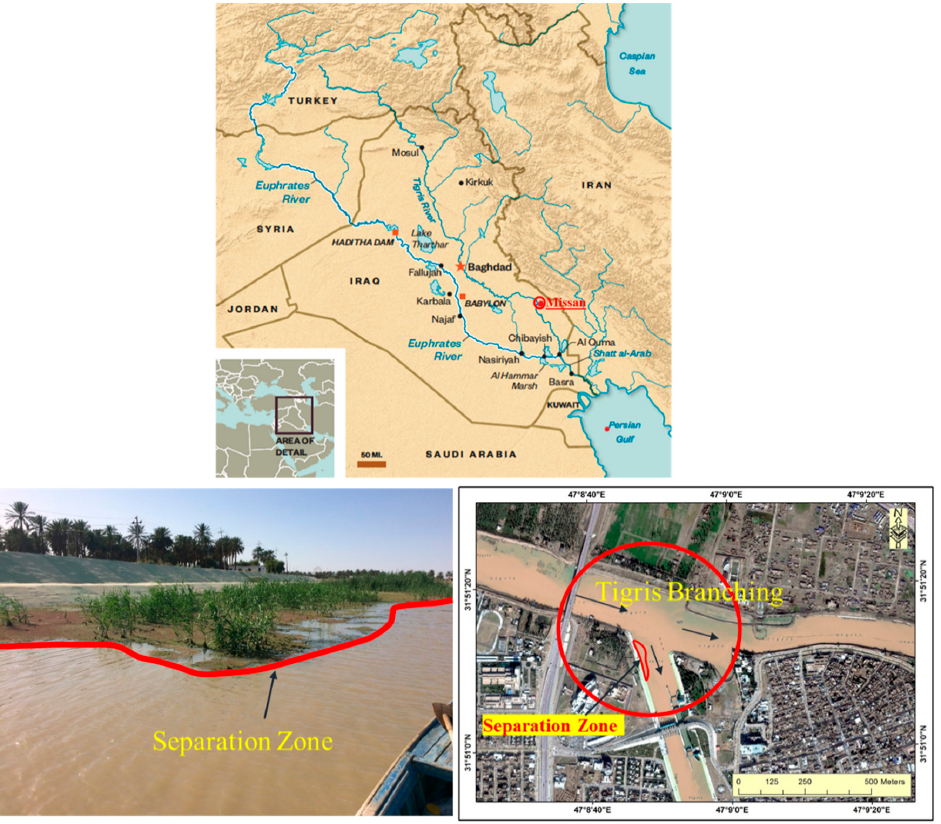
Figure 2. Tigris branching channel.